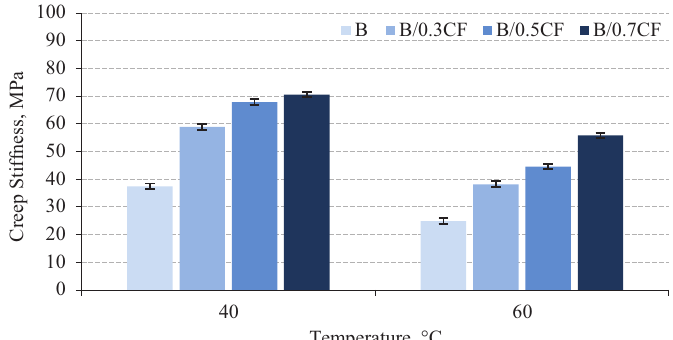
Figure 4. Creep Stiffness values of the control and carbon fibre asphalt